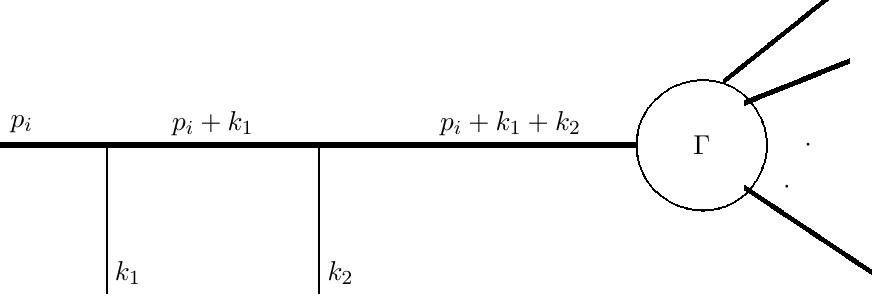
Figure 4 . Two external soft gravitons attached to the same external line carrying (cid:12)nite momenta.